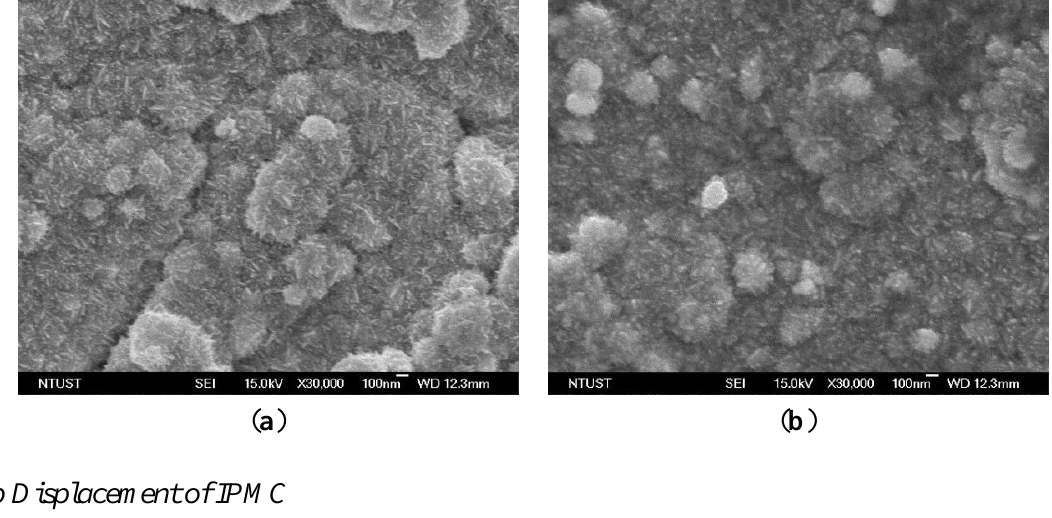
Figure 3. Top-view SEM micrographs of surface electrodes after ( a ) initial